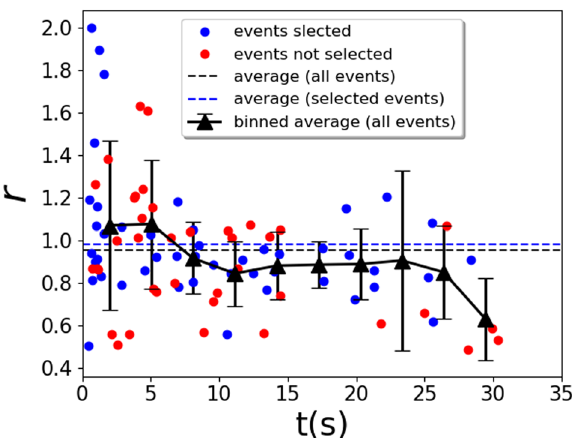
Fig. 6 r measured from 86 collision events (blue and red circles) during one experiment with the overall average value indicated by the black dashed line. When adopting the criterion of using those collision events with only unambiguously tracked trajectories before and after, 47 blue circles remain and give an average value indicated by the blue dashed line. Black triangles show the average values within every 3 s. Collision events after 30 s into cooling are too dif fi cult to be clearly detected due to the very slow motion of the particles and possible clustering